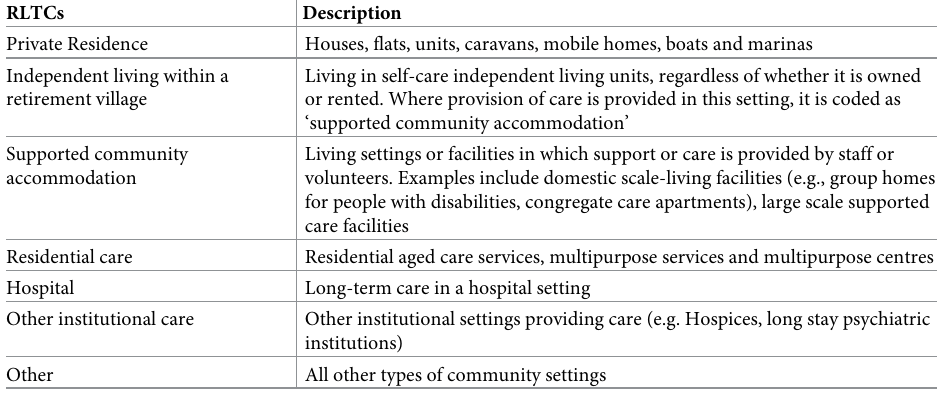
Table 1. The definitions of the recommended long-term care